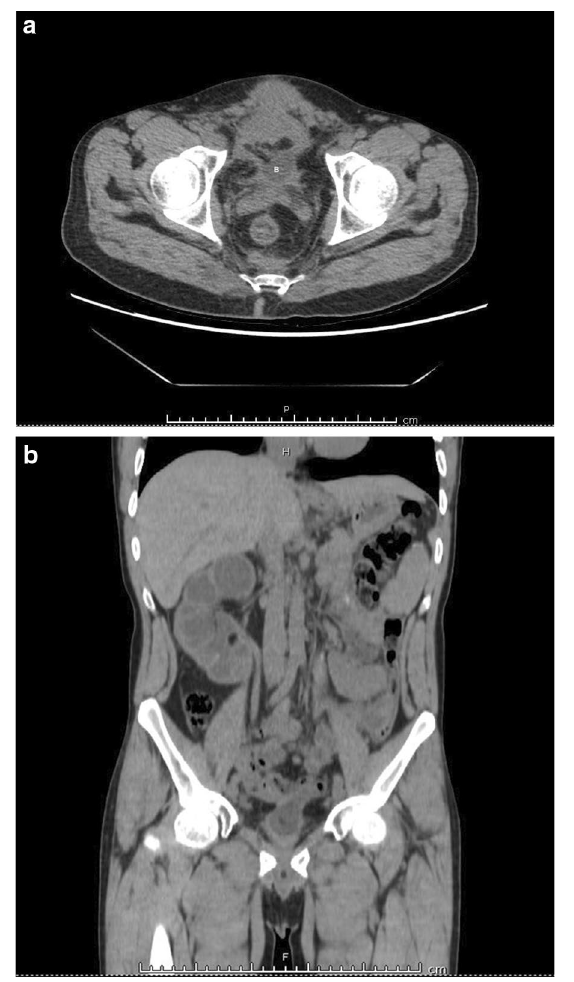
Fig. 1 Non-contrast computed tomography images. a Axial cut showing the shrunken small bladder filled by the Foleys balloon. b Coronal cut showing the grossly hydronephrotic right kidney with multiple dilated calyces due to multiple infundibular stenosis and small shrunken pelvis